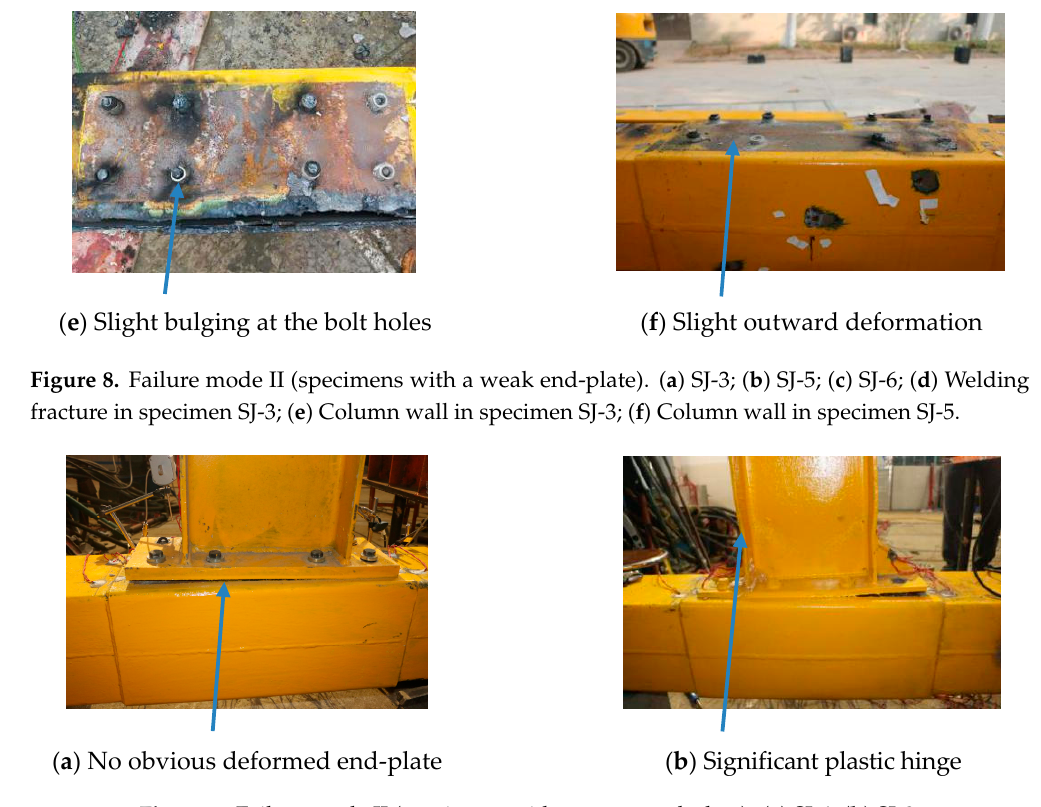
Figure 9. Failure mode II (specimens with a strong end-plate). ( a ) SJ-4; ( b ) SJ-8.